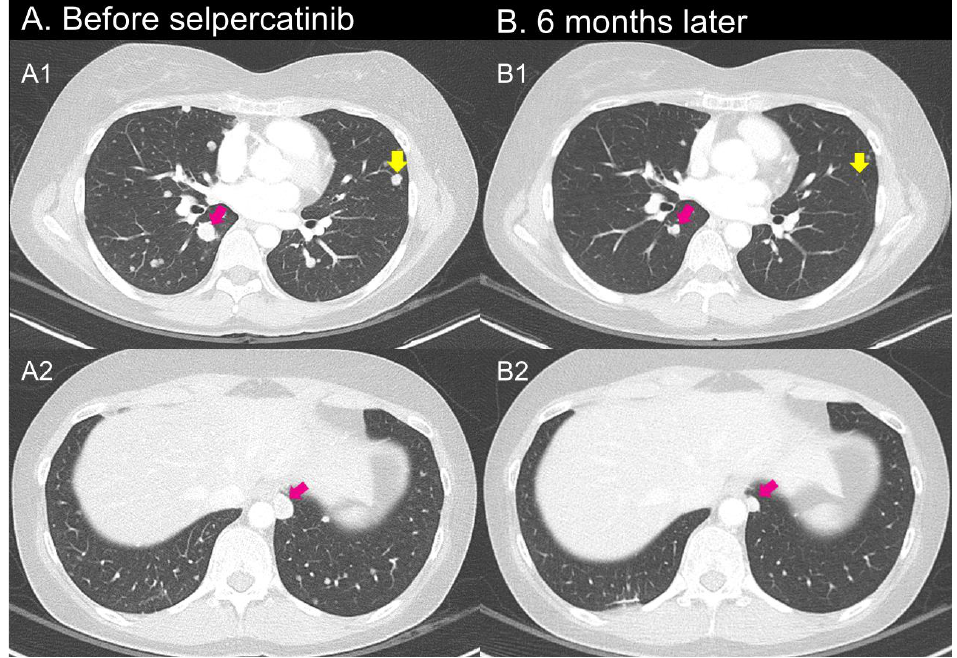
Figure 4. Before and at one month after selpercatinib treatment CT-scan of the patient in Case 3. Before treatment, there were metastatic lesions at hilar lesion, pleural, and lung parenchyme ( A1 , A2 ). After the treatment, all of them showed regression (yellow and purple arrows).